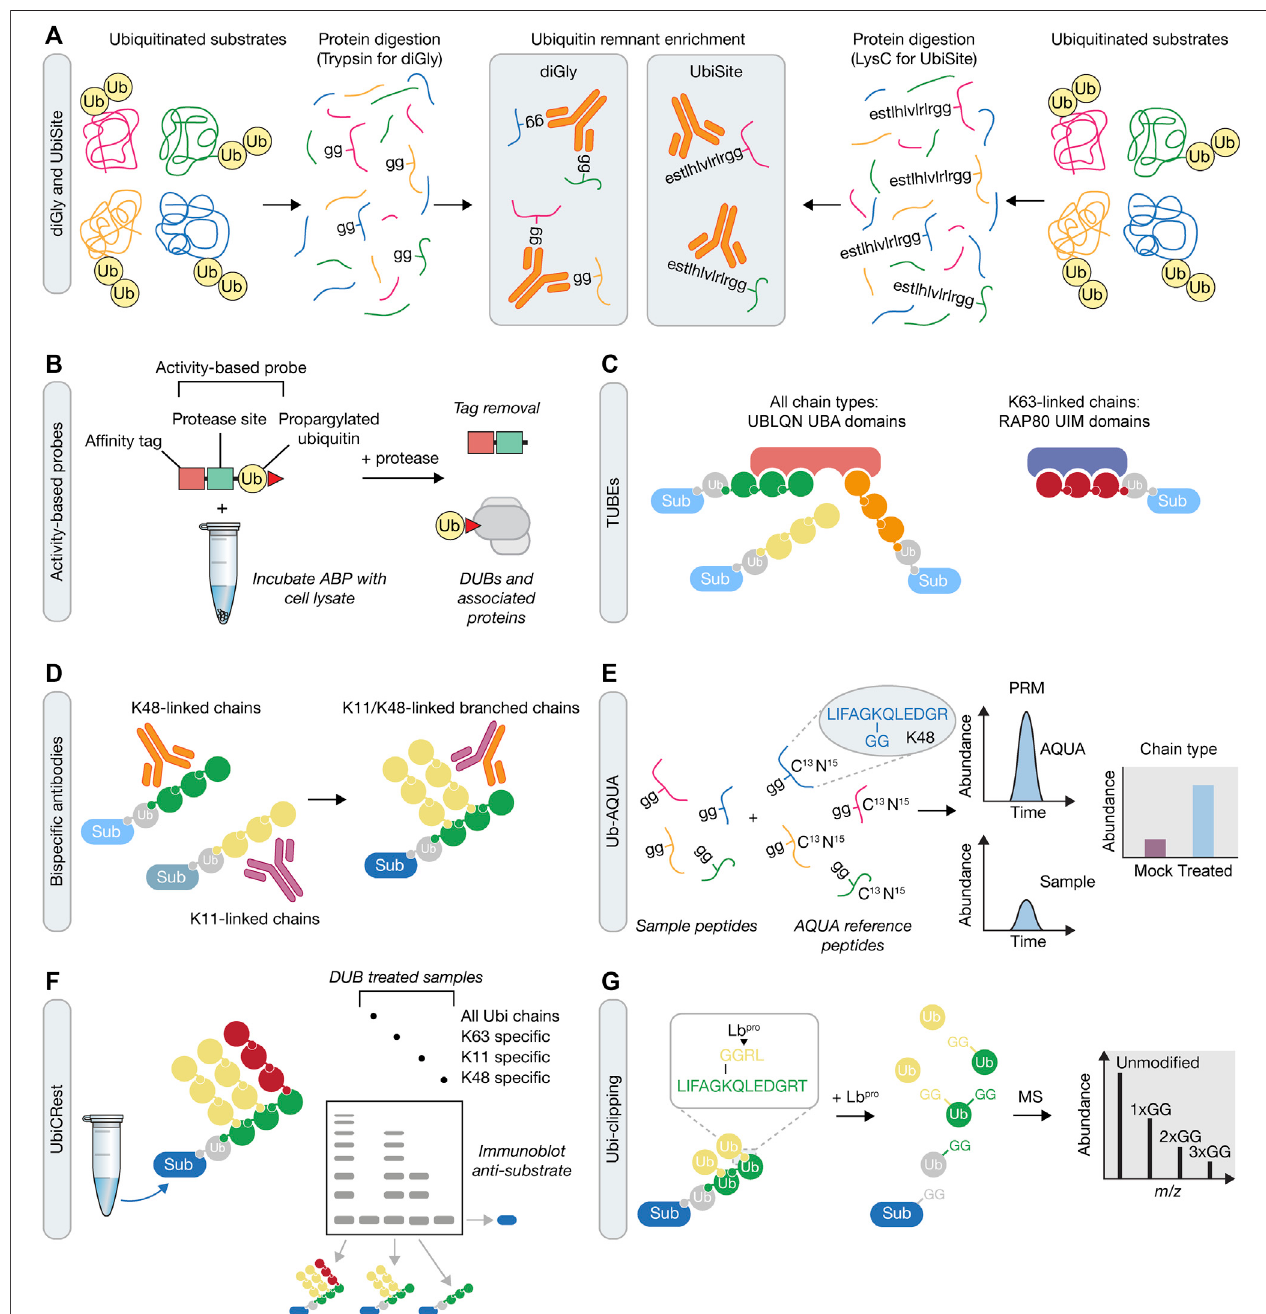
FIGURE 3 | Mass spectrometry approaches for understanding ubiquitin signaling. (A) Prior to mass spectrometry, ubiquitin remnants can be enriched following either trypsin or LysC protein digestion. These approaches rely on antibodies that recognise either the di-glycine (diGly) remnant peptide following tryptic digestion of ubiquitin using the K-GG antibody ( left ) , or a longer sequence that is recognized by the UbiSite antibody ( right ) . (B) Activity-based probe (ABP) tools in the UPS. Irreversiblereactivity oftheABPwithanenzyme ’ sactive site, inthiscase aDUB,enablespuri fi cation oftheprobe-enzymecomplex,prior todownstreamuse,e.g., for massspectrometry or crystallisation. (C) Tandem Ubiquitin Binding Entities (TUBEs) containa number ofspeci fi c ubiquitin binding domains that allow for the capture of polyubiquitinated proteins. TUBEs can be designed to capture all ubiquitin chain types (e.g., four UBA domains from UBLQN) or speci fi c ubiquitin chain types (e.g., three UIM domains from RAP80 that bind K63-linked chains). Sub, substrate. (D) In contrast to single ubiquitin linkage-speci fi c antibodies ( left ) , bispeci fi c antibodies ( right ) contain arms from each of these two antibodies that can be used to determine formation of branched ubiquitin chains in downstream assays, such as